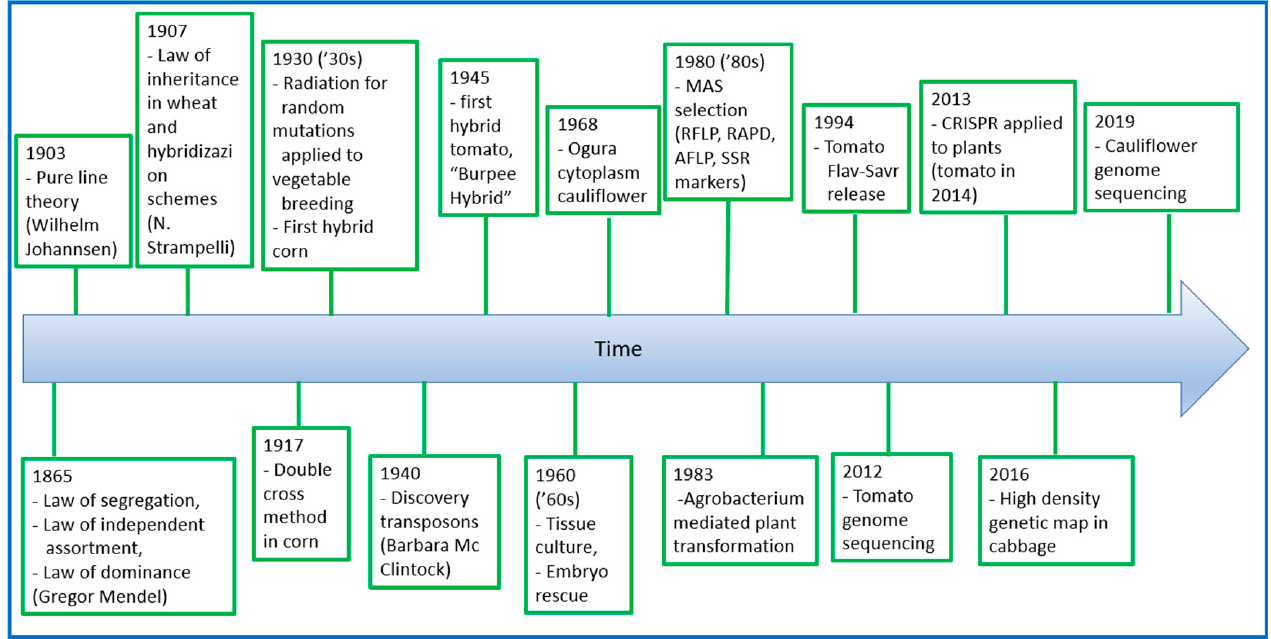
Figure 1. Milestones in vegetable breeding focused on tomato and cauliflower.